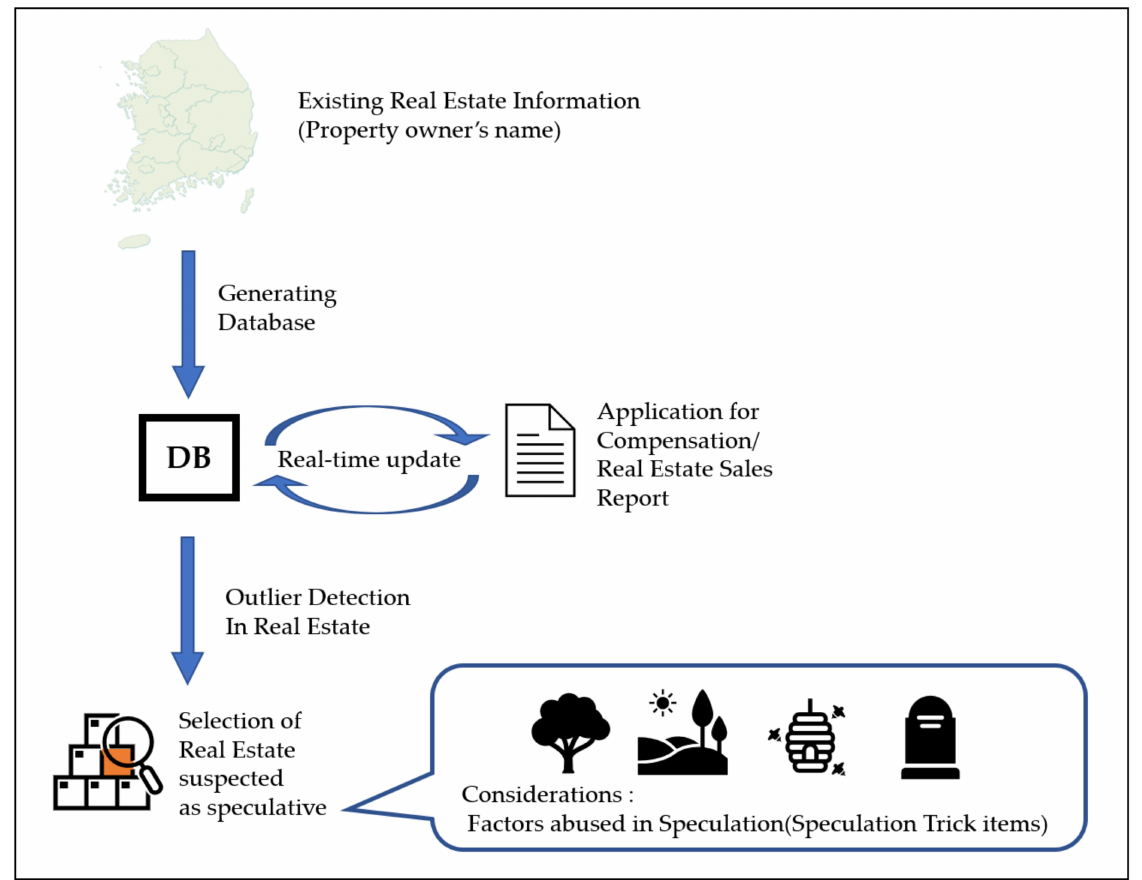
Figure 5. Outlier Detection for Selecting a Suspected Speculation